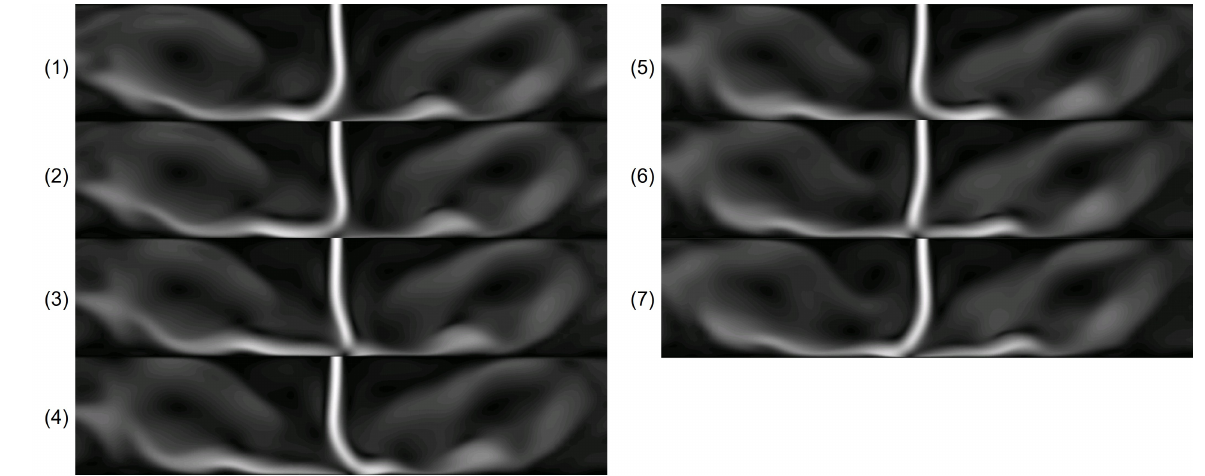
Figure 4. Flow visualization of a complete period for Re = 340.